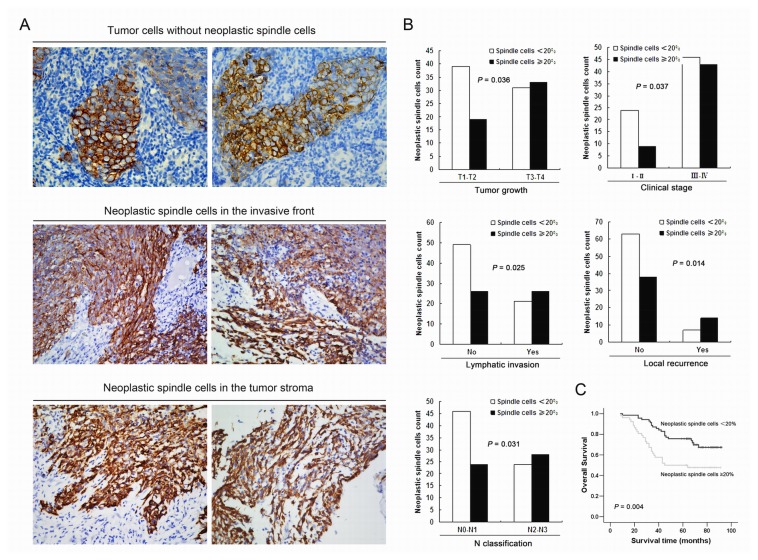
Spindle cells contribute to tumor aggressiveness and poor survival in NPC.(A) Representative examples showed that neoplastic spindle cells were frequently located at the invasive tumor edge or the invading surroundings (Pan-cytokeratin staining). (B) Correlation between the clinicopathologic characteristics and spindle cells in NPC. Columns: number of cases with >20% spindle cells vs <20. (C) Cumulative overall survival curves of 122 NPC patients according to the degree of spindle cells (≥20% vs <20%). Patients with high percentage of spindle cells (≥20%) had significantly shorter overall survival. P-values were calculated by the log-rank test.